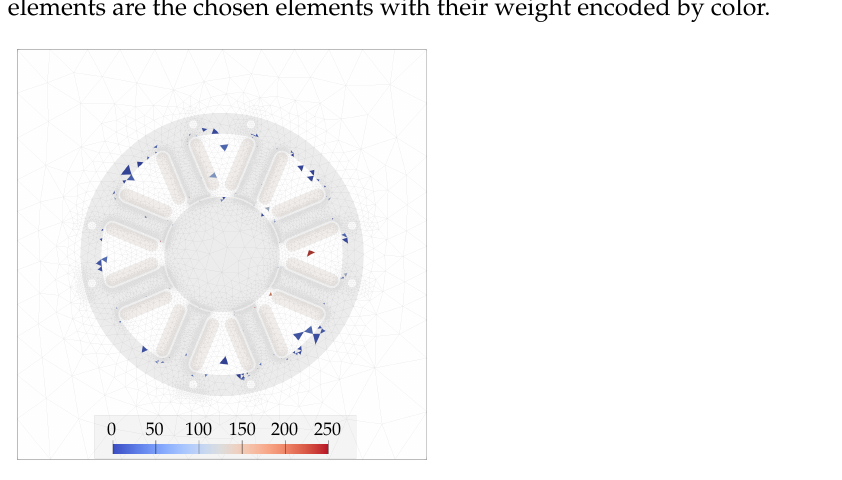
Figure 8. Exemplary ECSW-elements and corresponding weights of the reduced mesh